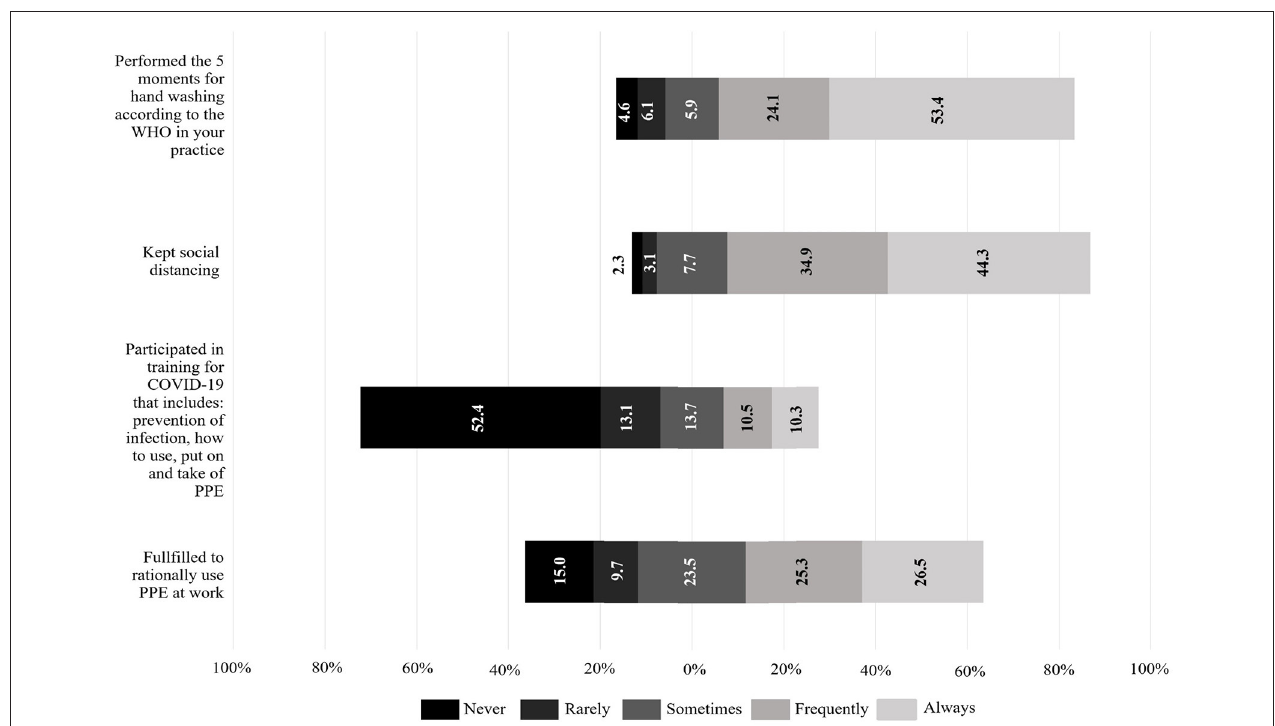
FIGURE 3 | Practices related to COVID-19 in healthcare workers. Bars indicate the proportion of patients according to their choice for each item in the practices dimension. Better practices tend to the right, worse attitudes tend to the left. Gray area (neither agrees nor disagrees) is placed in the middle. Figure was performed using Microsoft ® Excel ® version 2013 (Microsoft, Redmond, WA, United